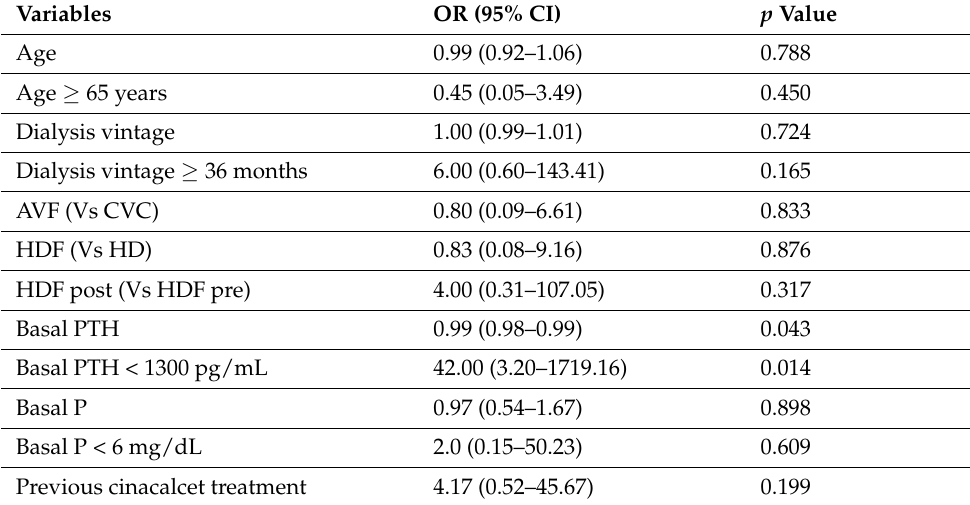
Table 7. Univariate logistic regression to achievement of PTH reduction endpoint ≥ 40% at 6 months. OR, odds ratio; CI, confidence interval.